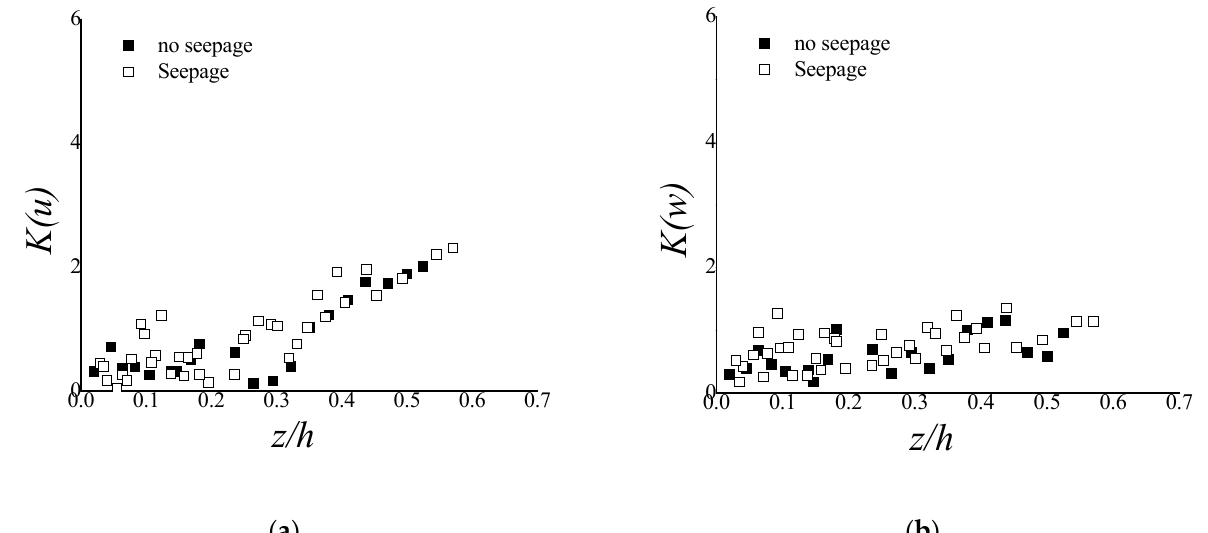
Figure 9. Kurtosis distributions ( a ) K ( u ) and ( b ) K ( w ) for all experiments in this study.